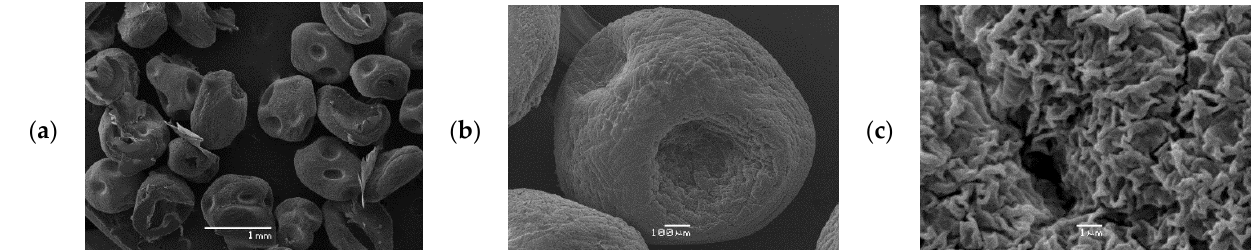
Figure 9. SEM pictures of CCCA microparticles dried in air, with different magnification ( a ) 1 mm, ( b ) 100 µm, and ( c ) 1 µm.